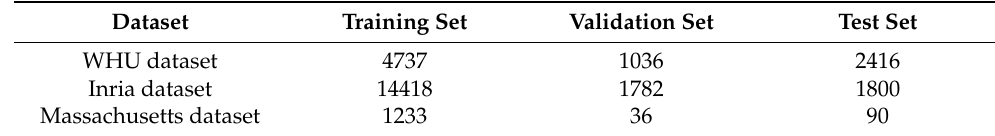
Table 2. Division of each dataset.